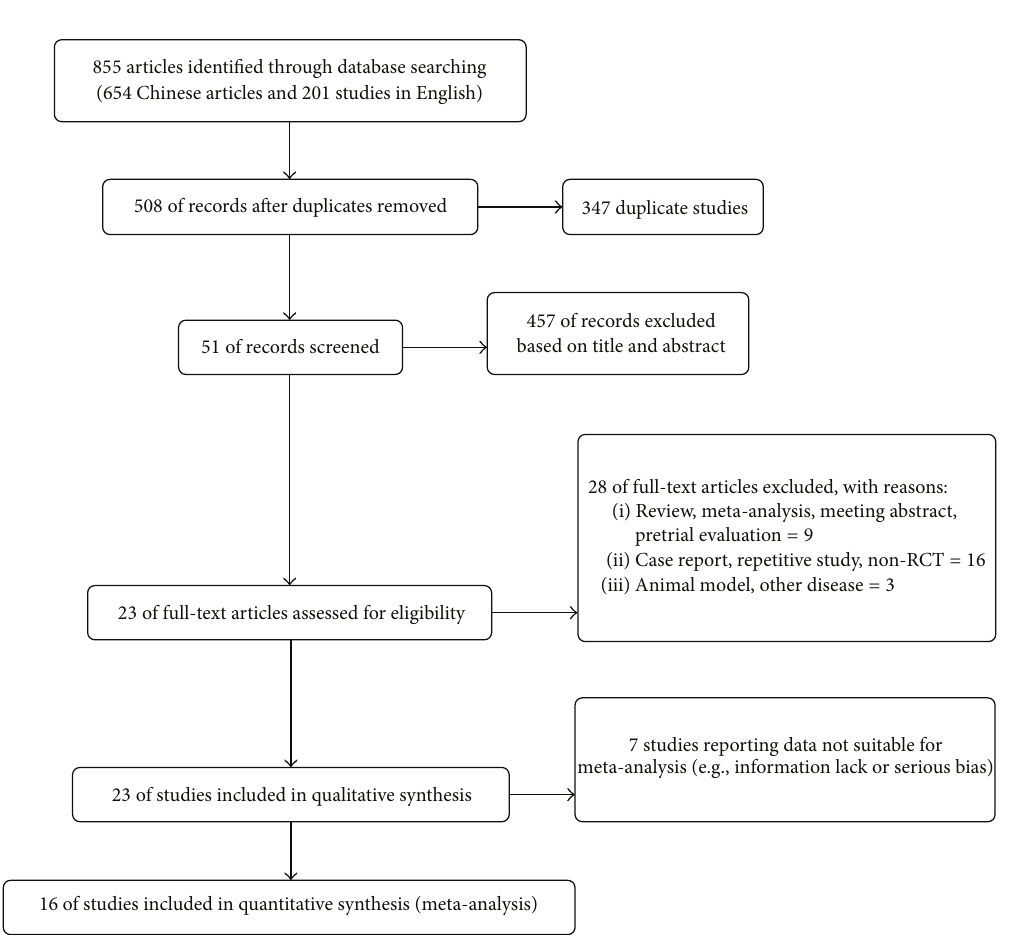
Figure 1: Flow diagram showing summary of study selection procedure.